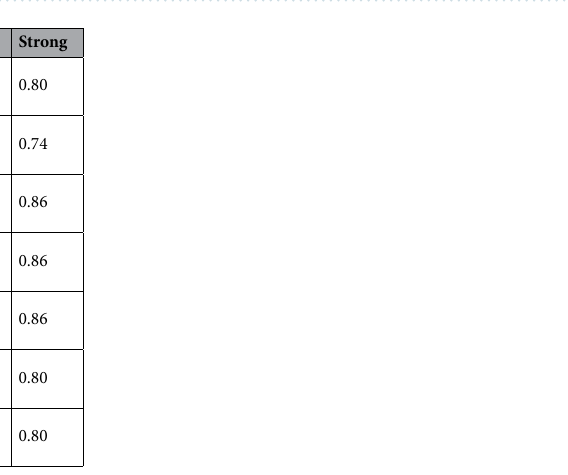
Table 13. The F 1 and accuracy in stacking combination